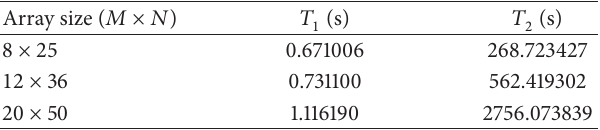
Table 1: CPU time for different array